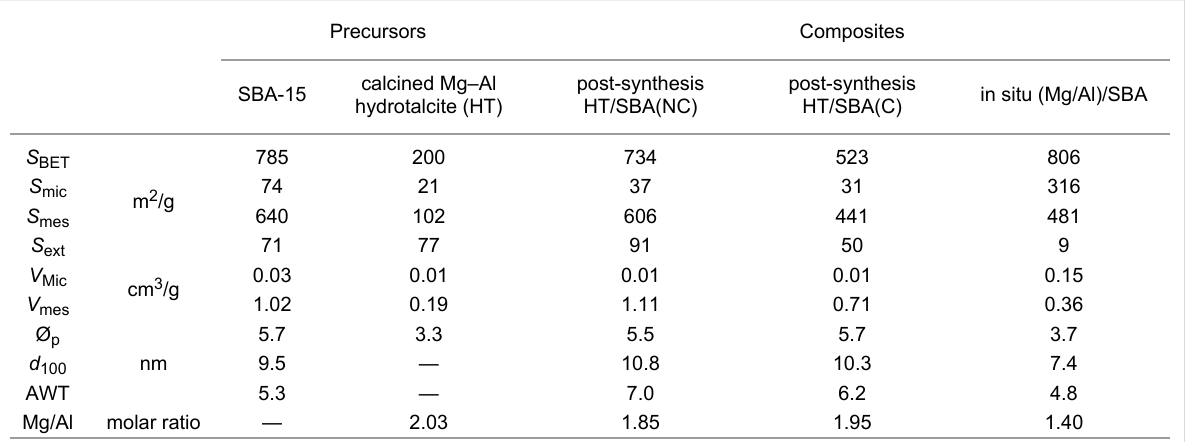
Table 1: Textural properties and Mg/Al molar ratio of the calcined samples.